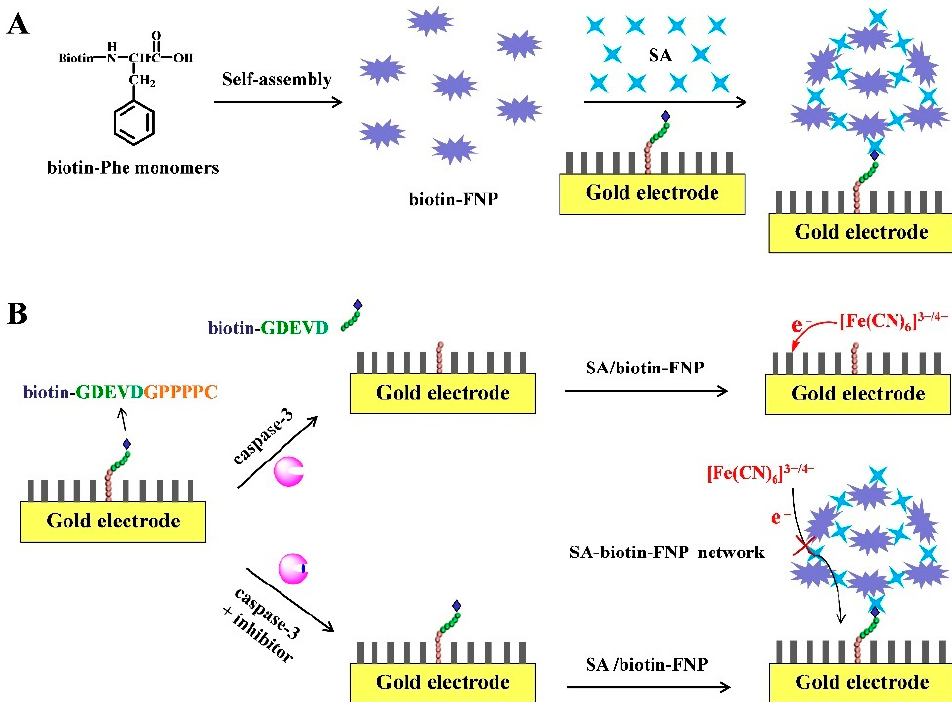
Figure 10. ( A ) Self-assembly of biotin–Phe monomers into biotin–FNP and the in situ formation of SA–biotin–FNP networks on the electrode surface. ( B ) Schematic representation of the biosensor for assay of caspase-3 activity via the signal amplification by SA–biotin–FNP networks [85]. Copyright 2020 Elsevier B.V.